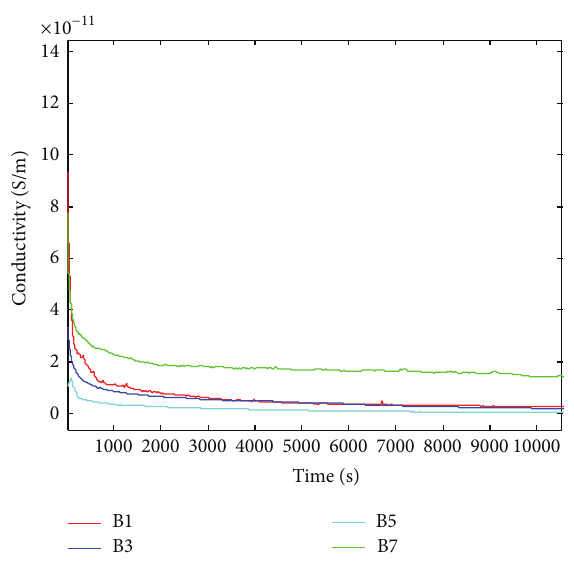
Figure 10: Conductivity variations for sample LLDPE-NR/TiO 2 at different amount of